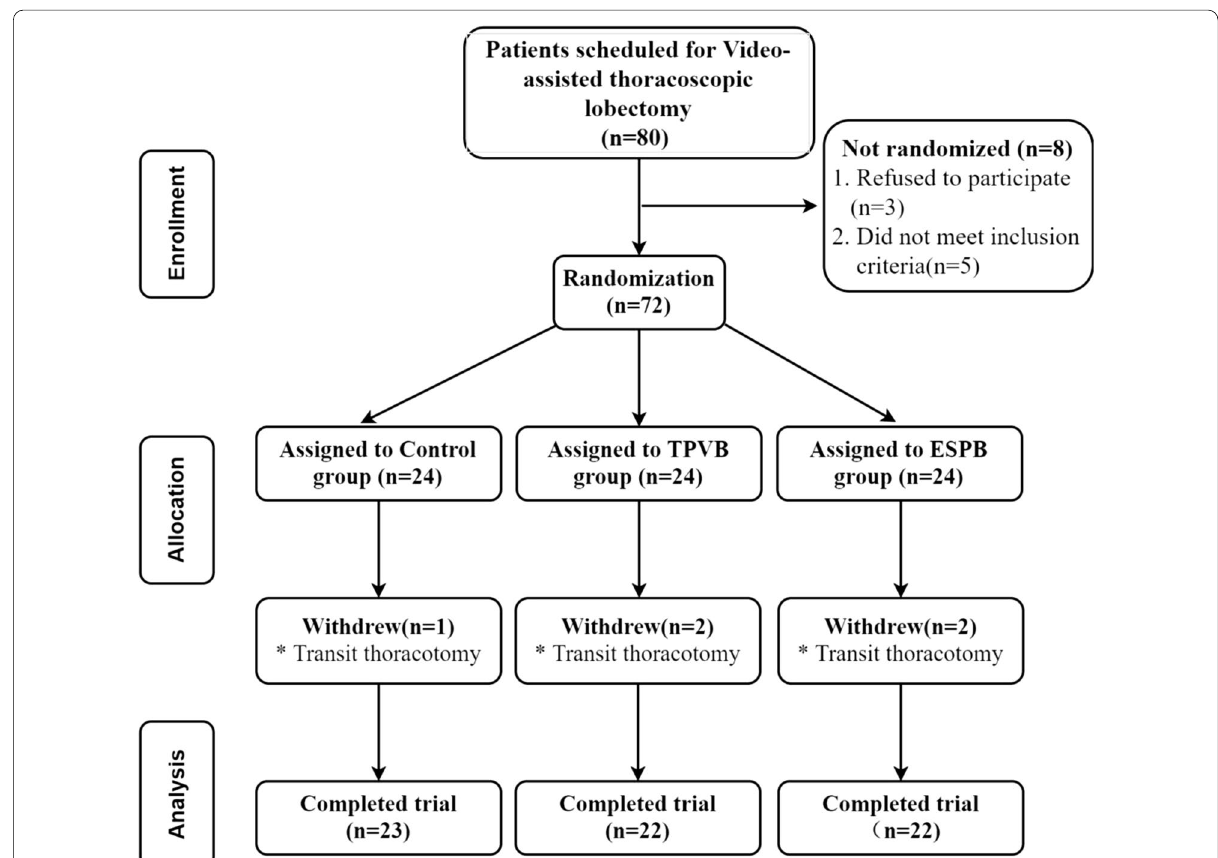
Fig. 2 The flow chart of the participants. Note TPVB: Thoracic paravertebral nerve block; ESPB: Erector spinae plane block